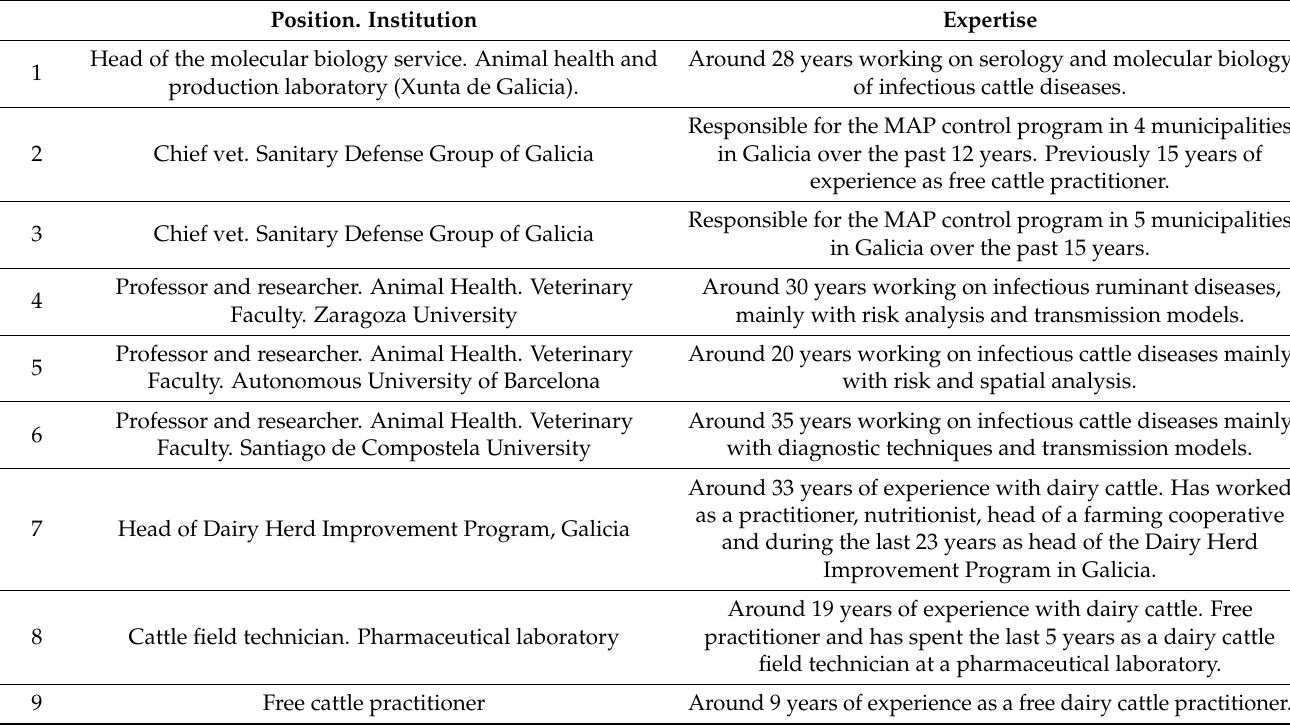
Table A1. Background and expertise of the different experts who participated in the